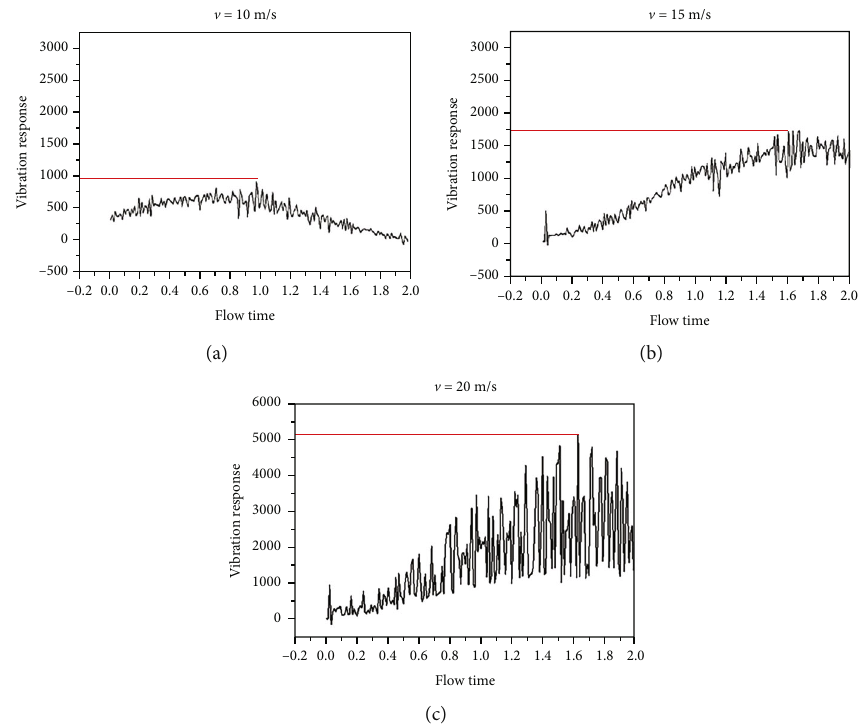
Figure 6: Wind-induced vibration responses of the wave-shaped roof at di ff erent wind speeds, v = 10 m/s (a), v = 15 m/s (b), and v = 20 m/s (c). The red line indicates the maximum vibration response